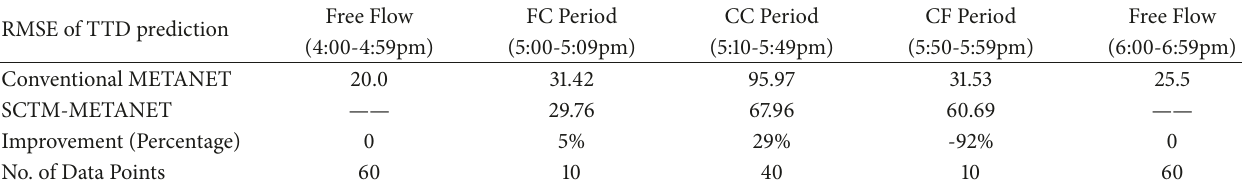
Table 3: Quantitative comparison of METANET and SCTM-METANET Models: